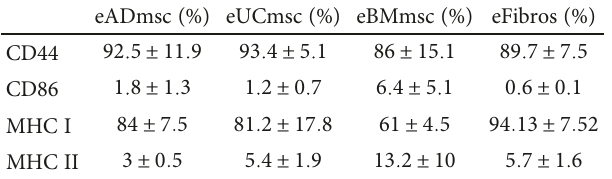
Table 2: Percentage of the mean fl uorescence of the surface markers CD44, CD86, MHCI, and MHCII in all equine somatic cells studied. After the fl ow cytometric analysis, the elevated expression of CD44 and MHCI and decreased expression of CD86 and MHCII were detected. No signi fi cantly di ff erent results were